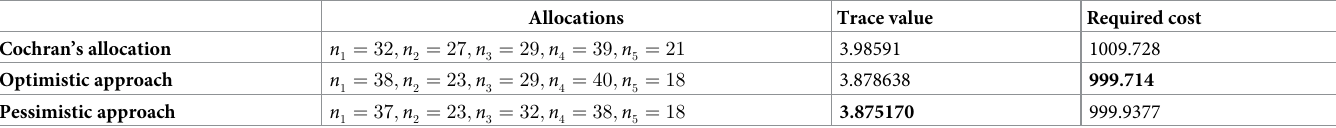
Table 4. Allocation of trace value with incurred survey cost for complete response case.